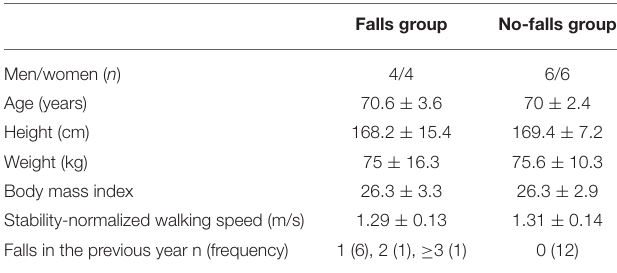
TABLE 1 | Participant characteristics (mean ± SD).